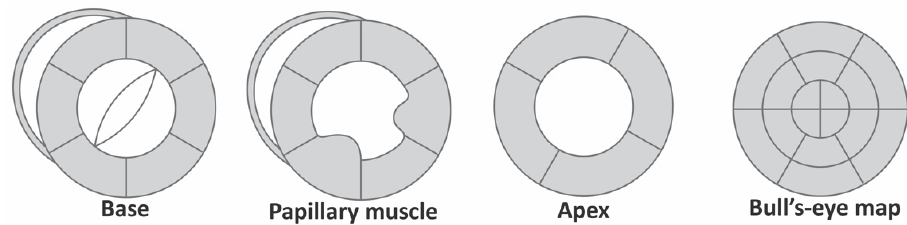
Figure 4. Schematic representation of short axis views at the base, papillary muscle and apical levels and bull’s-eye map created by superimposing all three.